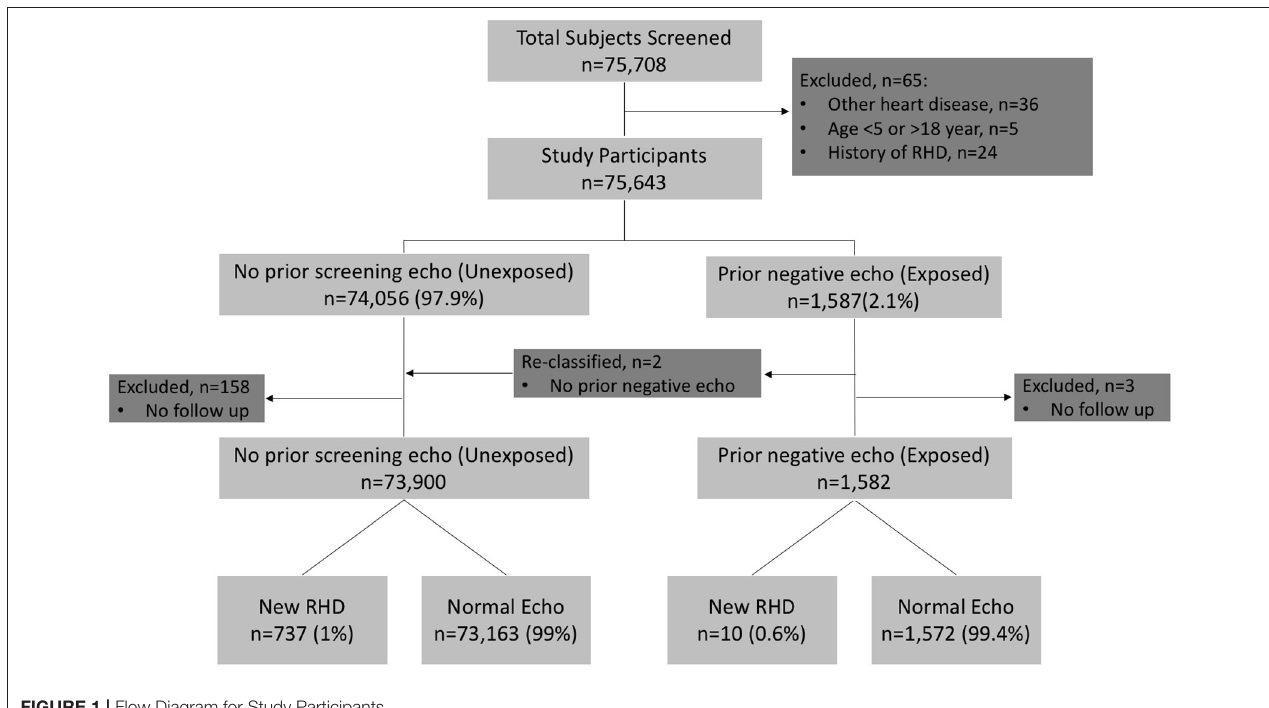
FIGURE 1 | Flow Diagram for Study Participants.